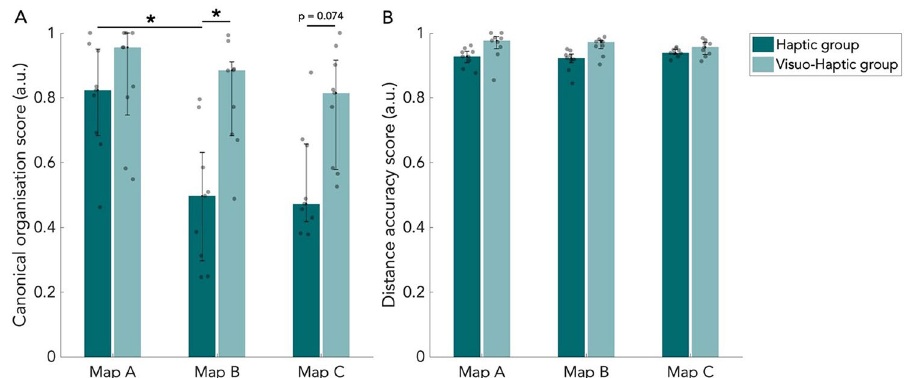
Figure 5. Scores of the rebuilding task. Median scores of the rebuilt maps. Results are shown for all three maps and both the haptic (n = 9) and visuo-haptic group (n = 9). Error bars indicate the 25th and 75th percentiles. Grey dots are individual data points. ( A ) Median canonical organization scores. ( B ) Median distance accuracy scores. * p < 0.05, corrected for multiple